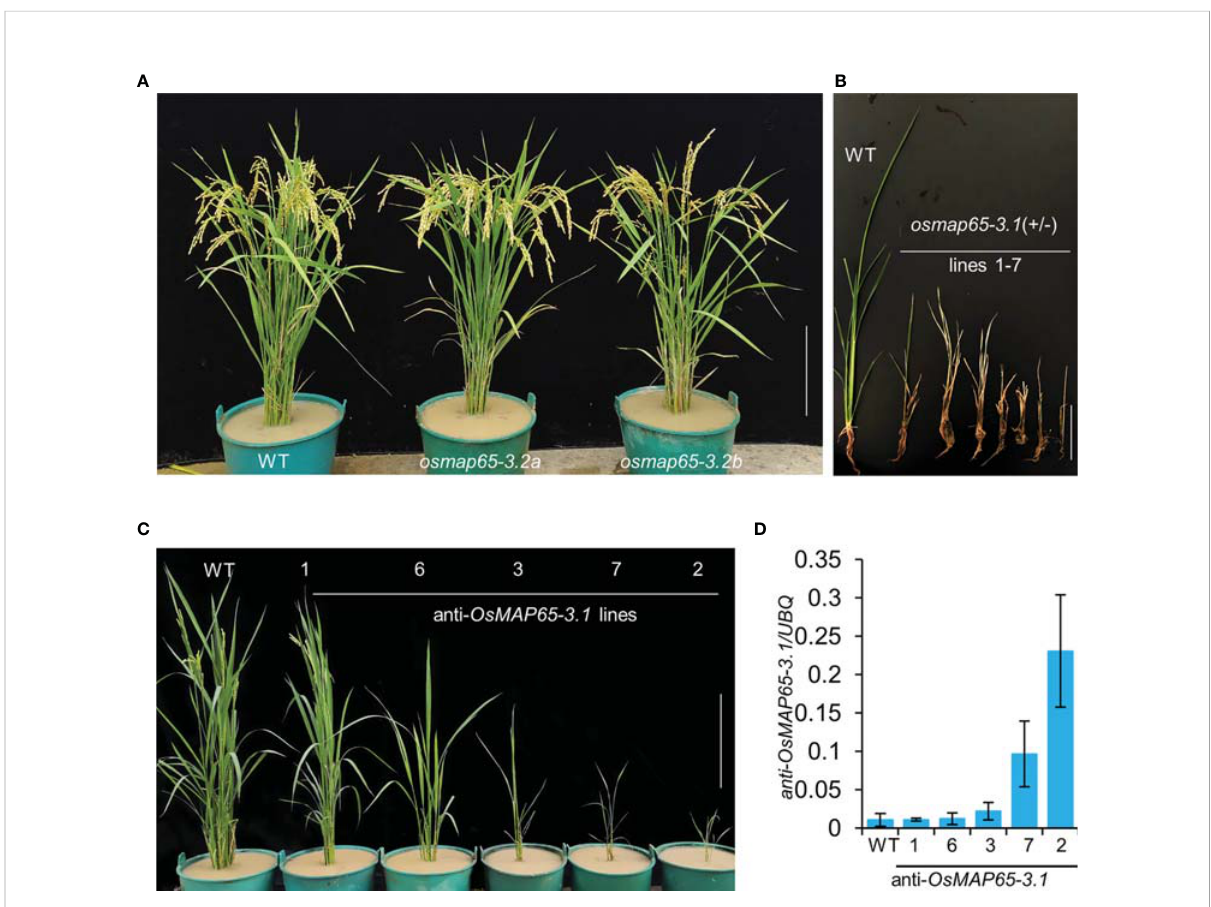
FIGURE 5 Developmental phenotypes of osmap65-3.1 and osmap65-3.2 defect plants. (A) Phenotypes of the wild-type and osmap65-3.2 mutants at the fi lling stages. (B) Lethal phenotype of osmap65-3.1(+/-) at the seedling stage. (C) Suppressed growth of anti- OsMAP65-3.1 plants; (D) Transcriptional levels of anti-sense OsMAP65-3.1 . The roots at the seedling stage were used for qRT-PCR, and the UBQ gene was used as a control. Mean and SD values were obtained from three biological replicates. Bar = 20 cm (A, C) , 5 cm (B)